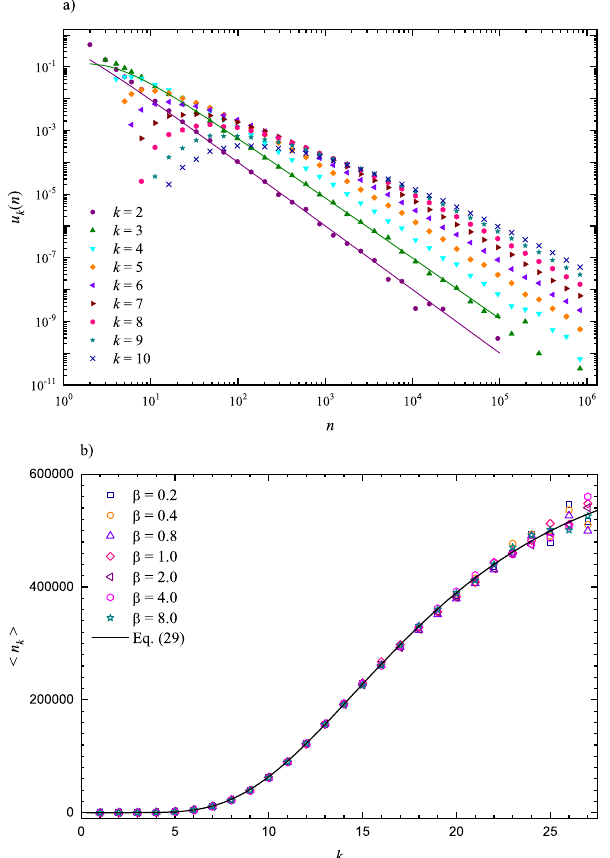
Figure 4. ( a ) The distribution of times of the k th record breaking event, u k ( n ) , are shown for the first several orders of k = 2,3, . . . ,10. The solid lines were computed using the recursive formula, Equation (17); ( b ) the average time (cid:104) n k (cid:105) of the occurrence of the k th record-breaking event for several values of the Weibull model